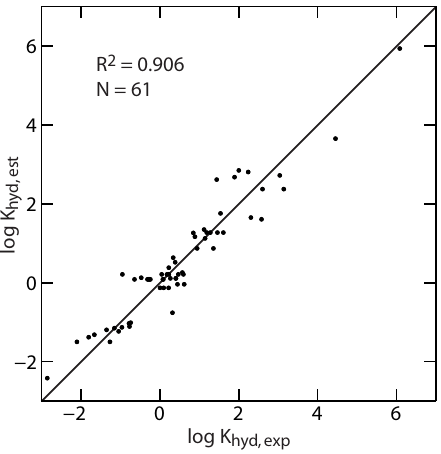
Fig. 1. Estimated hydration constant versus experimental values. The line is the y = x